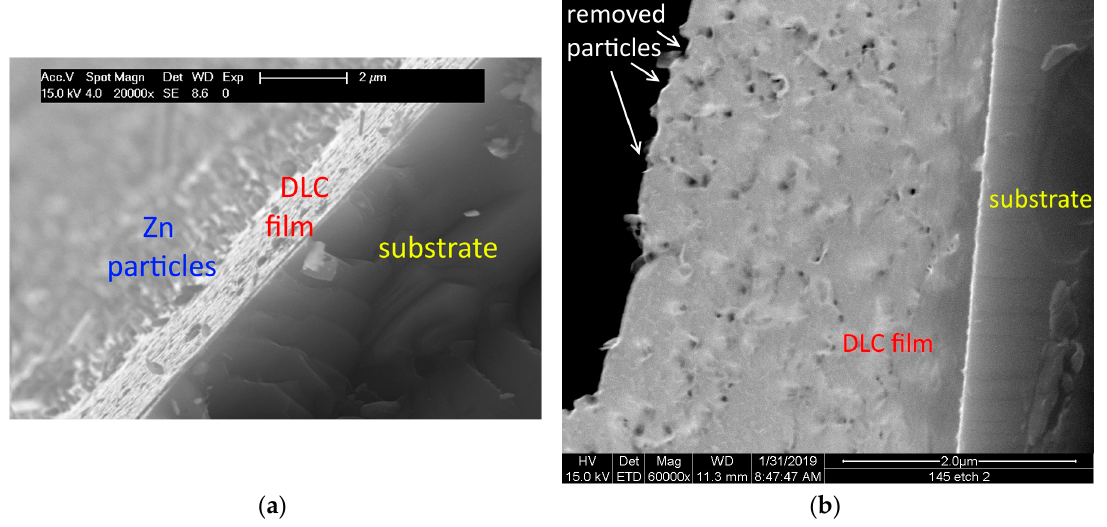
Figure 2. Cross-sectional SEM images of the sample with 9.6 at.% Zn on the surface: ( a ) as prepared; ( b ) after etching.